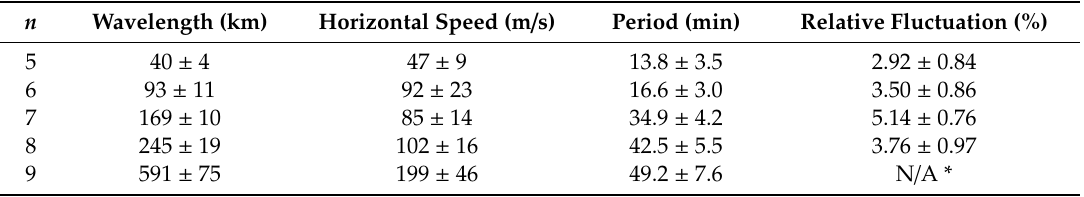
Table 2. Wavelength, horizontal speed, and relative fluctuation of quasi-monochromatic GWs with di ff erent scales. The values listed are the average and variance of multiple